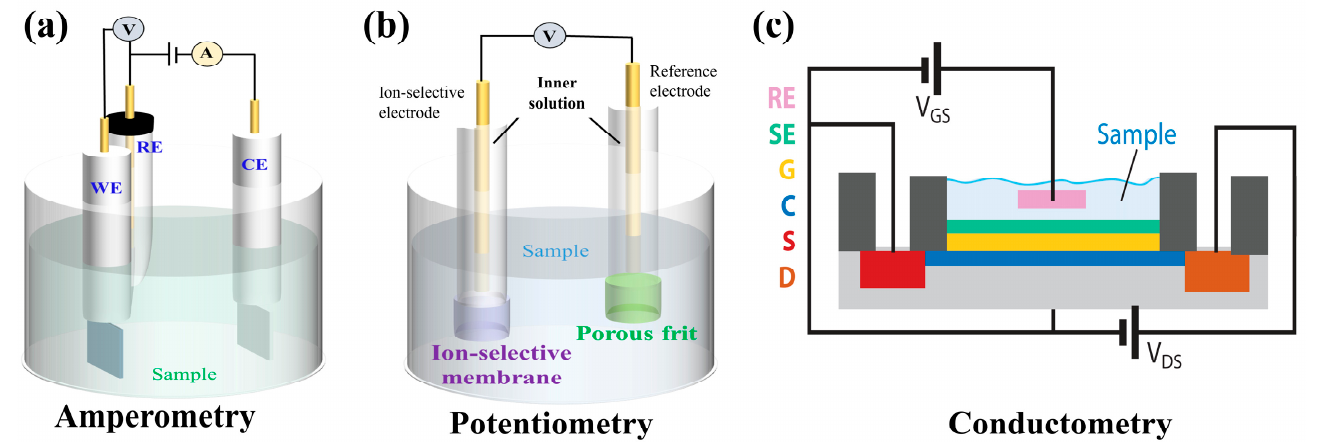
Figure 2. Schematic of the working principles for different types of electrochemical biosensors: ( a ) Amperometry (WE: Work Electrode, RE: Reference Electrode, CE: Counter Electrode), ( b ) Potenti- ometry, ( c ) Conductometry. Reprinted with permission from ref. [46]. Copyright 2019 Annual Re- views.